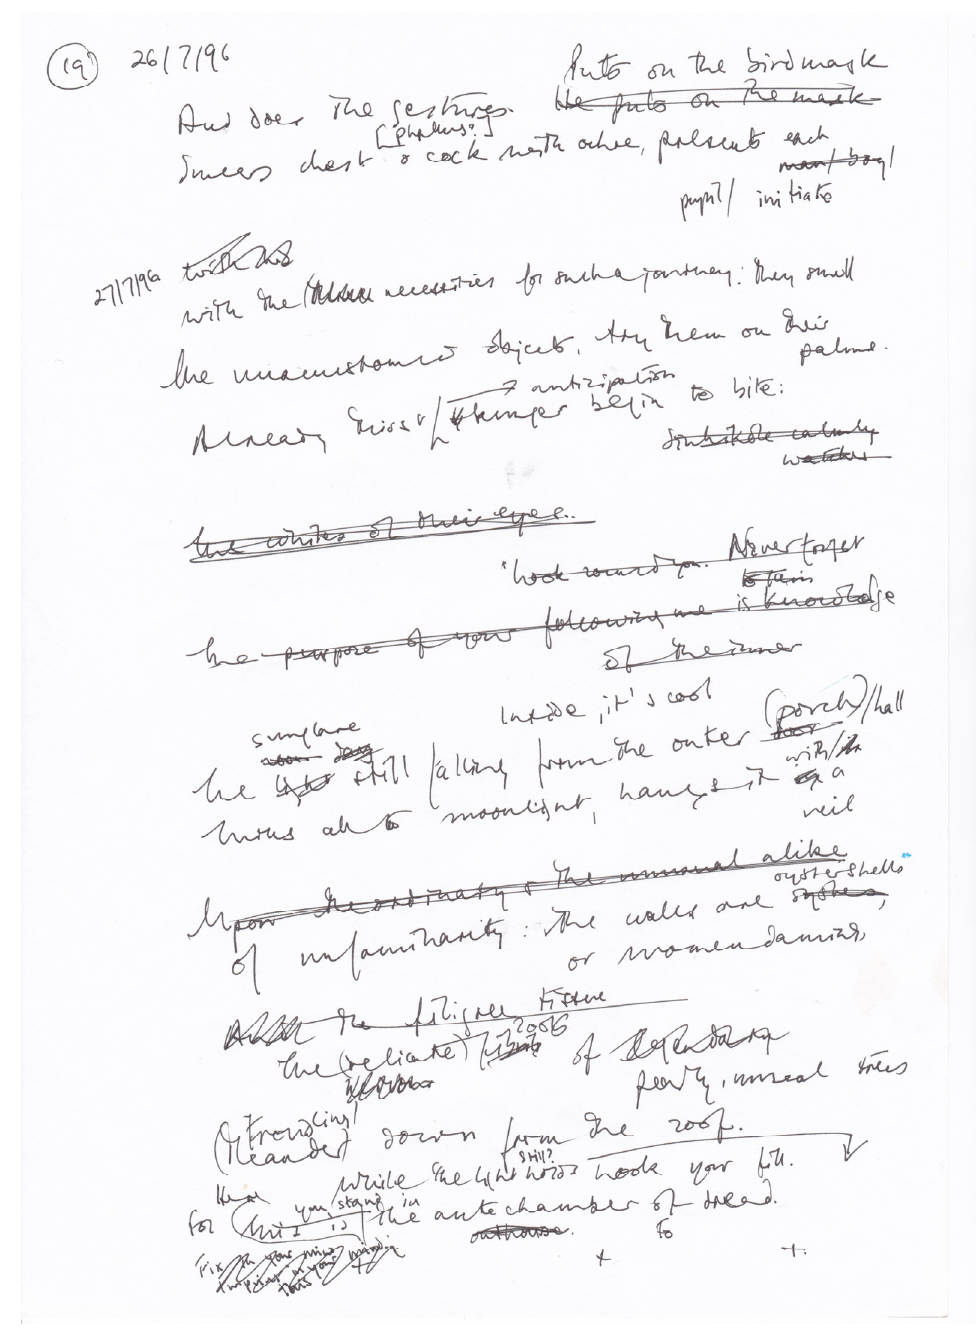
Figure A2. Omphalos